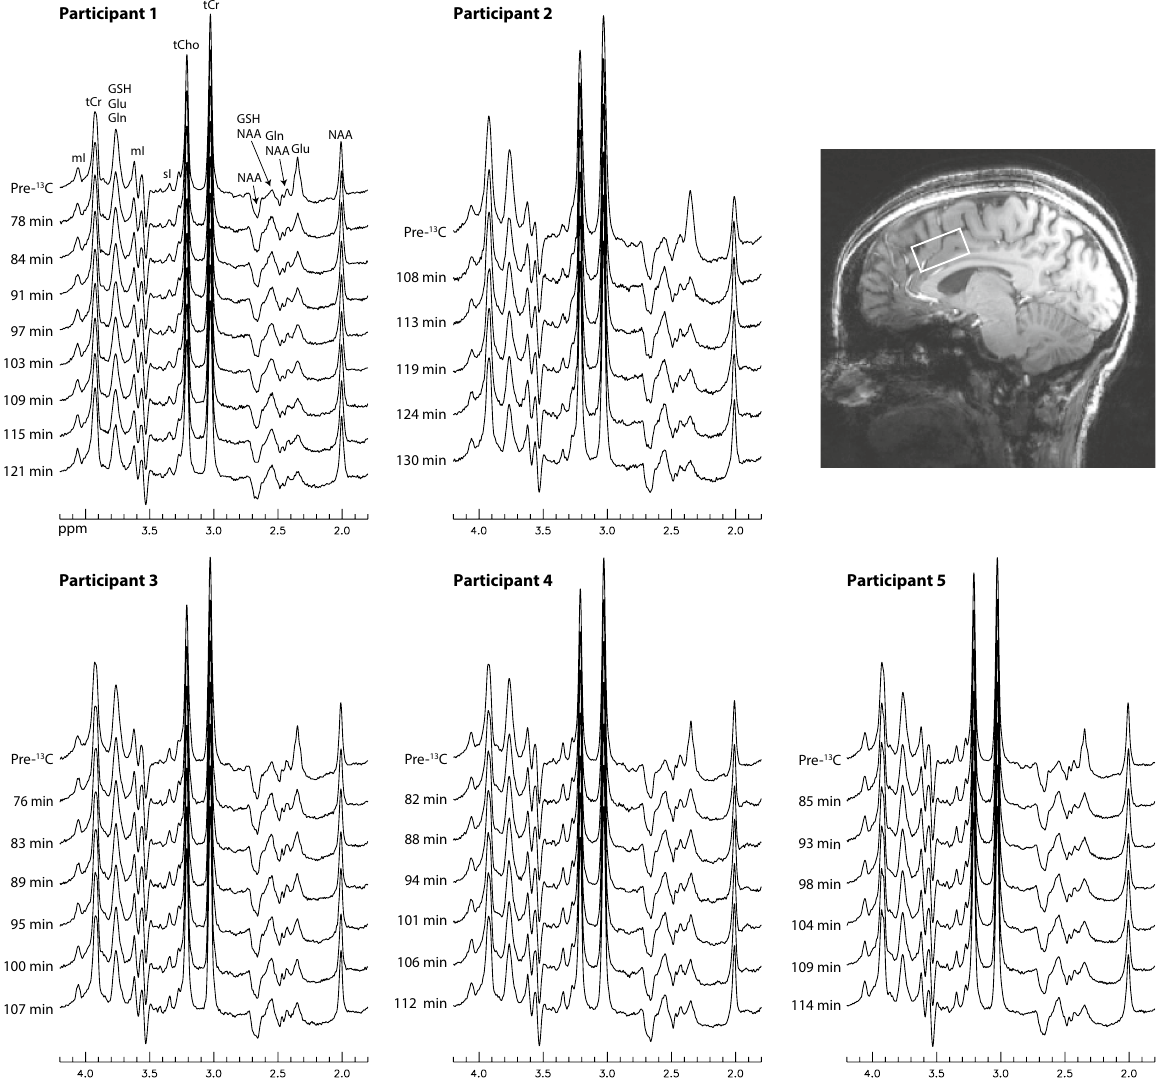
Figure 2. Time-course 1 H spectra from the dorsal anterior cingulate cortex (dACC) of five healthy participants. No linebroadening was applied to the in vivo spectra. The listed times are the mid-point times of the MRS scans. Voxel size = 3.5 × 1.8 × 2 cm 3 ; TR = 2.2 s; TE = 56 ms; spectral width = 4000 Hz; number of data points = 1024; number of averages = 264 and total scan time = 10 min for the pre- 13 C spectra; number of averages = 132 and total scan time = 5 min for each individual post- 13 C spectrum. The time course acquisition was initiated after the participants drank the glucose solution, rested, and then re-entered the